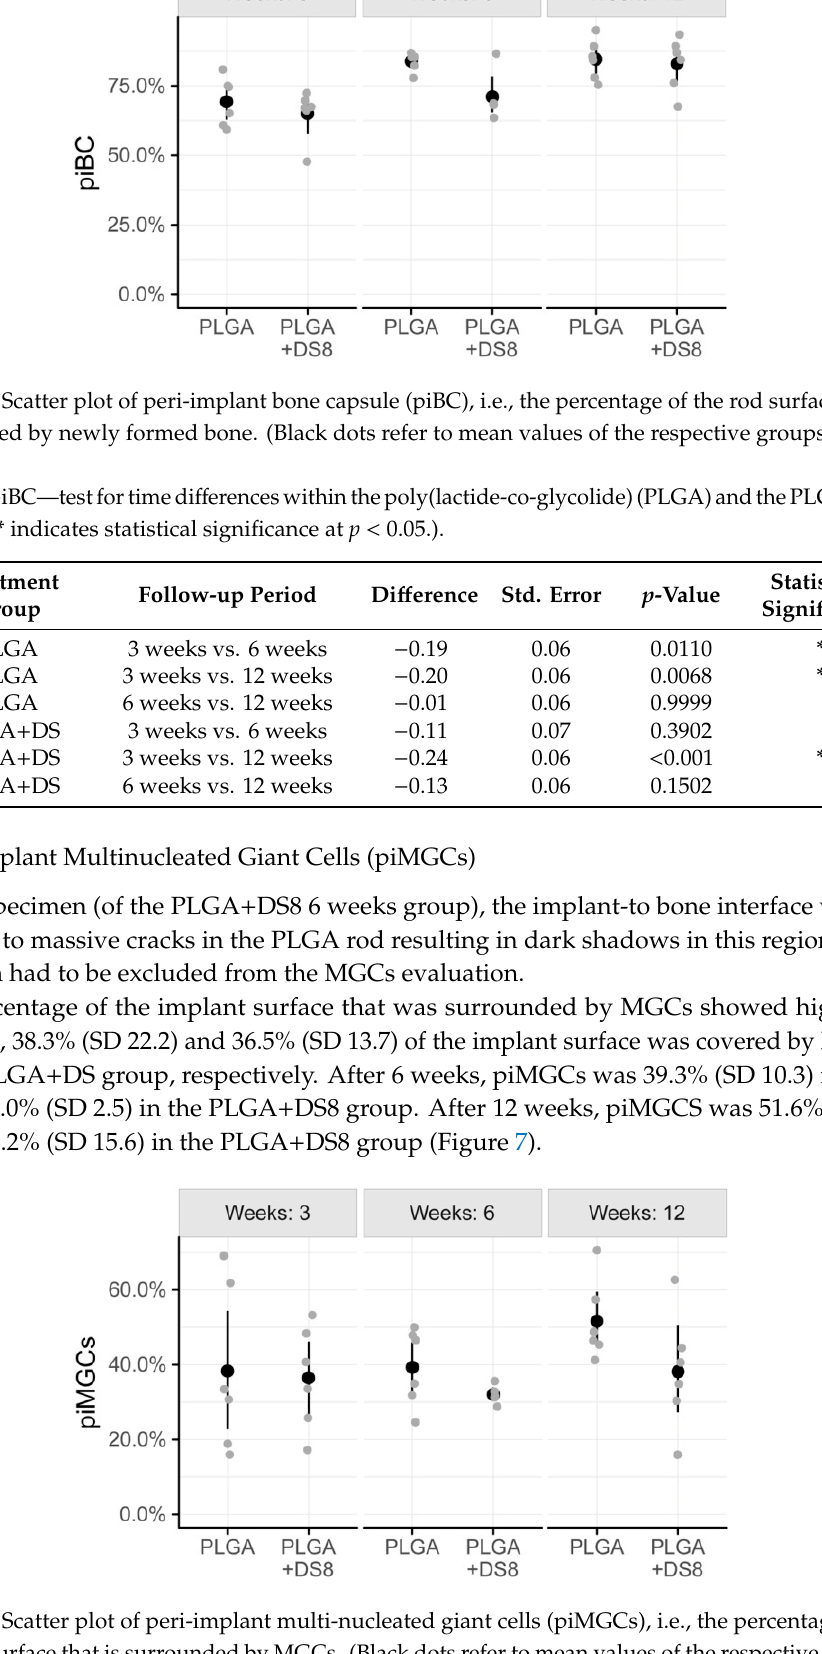
Figure 6. Scatter plot of peri-implant bone capsule (piBC), i.e., the percentage of the rod surface that is surrounded by newly formed bone. (Black dots refer to mean values of the respective groups).